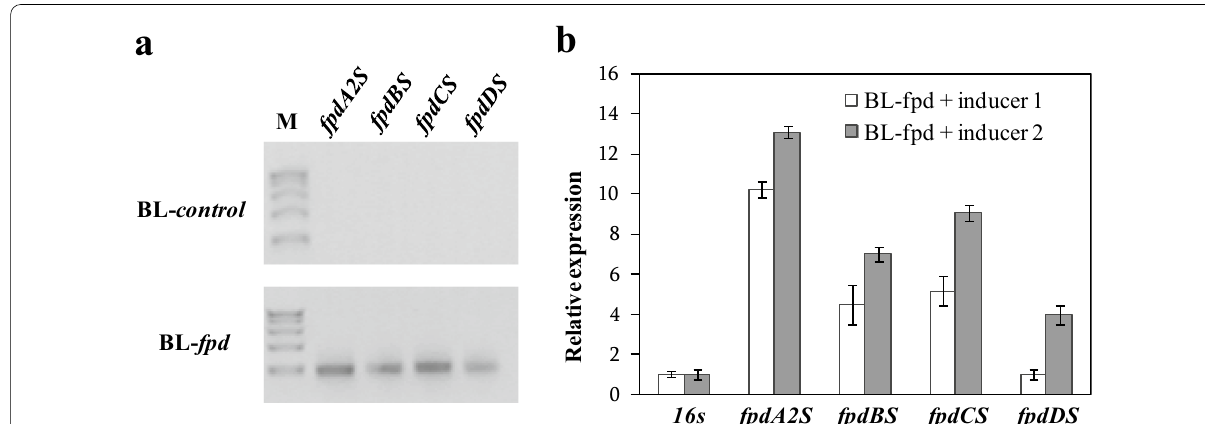
Fig. 2 Expression of 4-FP degradation pathway genes. a PCR amplified fragments using plasmid from BL- control or BL- fpd as the template (M, DL2000). The plasmids were extracted when OD 600 reached 0.6 after being cultured in LB medium; b Relative transcript level analysis of the exogenous genes in BL- fpd at different concentrations of inducers by qRT-PCR. The relative expression values of the genes (relative to the internal control 16S gene) were calculated by 2 –ΔCT 2 − [CT(target) − CT(16S)] . inducer 1 (0.2 g/L final concentration of L-arabinose and 0.1 mM final concentration = of IPTG), inducer 2 (2 g/L final concentration of L-arabinose and 1 mM final concentration of IPTG). Values are the mean SD of three ±